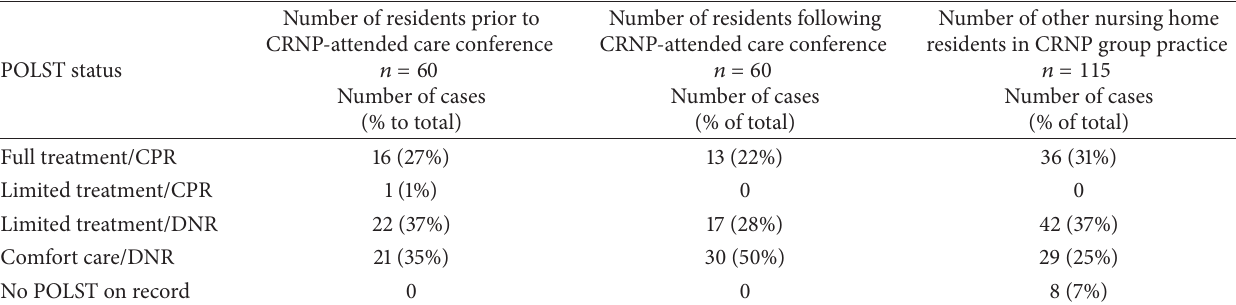
Table 3: POLST status of nursing home residents prior to and following CRNP-attended care conference versus other nursing home residents in the provider group